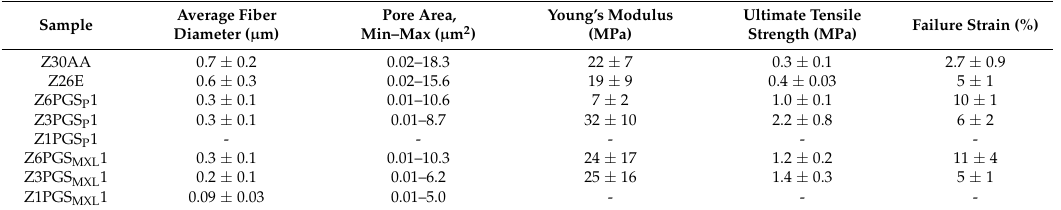
Table 2. Average fiber diameter, pore area and mechanical properties of the distinct fiber